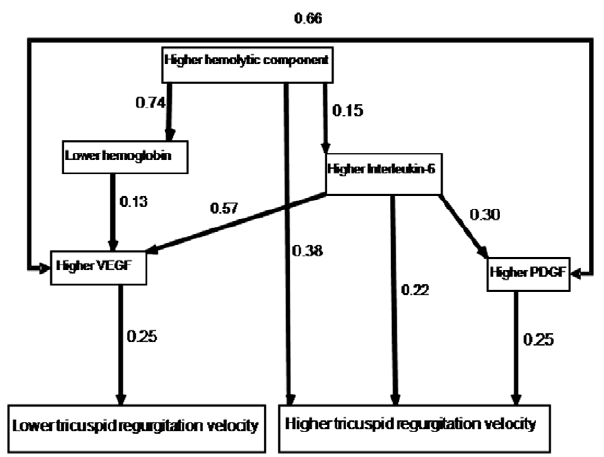
Figure 3. Pathway analysis of tricuspid regurgitation velocity in sickle cell disease patients. The numbers shown are standardized betas. Each of the arrows depicts a significant relationship (P , 0.05). According to this analysis, higher hemolytic component was a direct predictor of increasing tricuspid regurgitation velocity and it also was associated with lower hemoglobin concentration and higher interleu- kin-6 concentration. Lower hemoglobin concentration was not a direct predictor of higher regurgitation velocity, but it was associated with higher VEGF concentration. Higher interleukin-6 concentration was a direct predictor of increasing tricuspid regurgitation velocity and it also was associated with higher VEGF and PDGF-BB concentrations. Higher PDGF-BB concentration was a direct predictor of increasing regurgita- tion velocity while higher VEGF concentration was a direct predictor of lower regurgitation